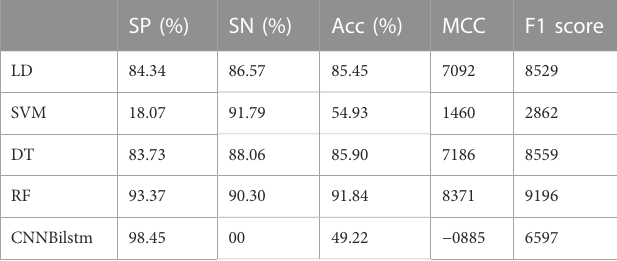
TABLE 6 The performances of combination